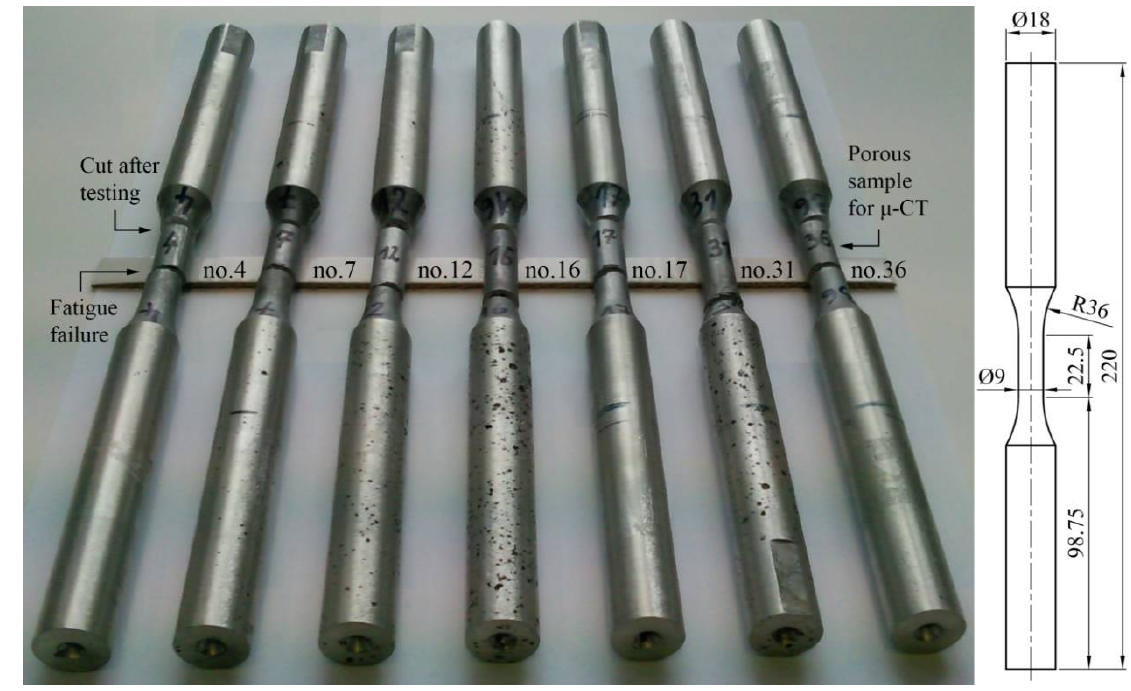
Figure 2. ( Left ) specimens from AlSi9Cu3 alloy with clusters of macro pores (after the low-cycle fatigue experiments); ( right ) design drawing of a specimen (dimensions are in (mm)). Table 2. AlSi9Cu3 alloy designation according to different standards.